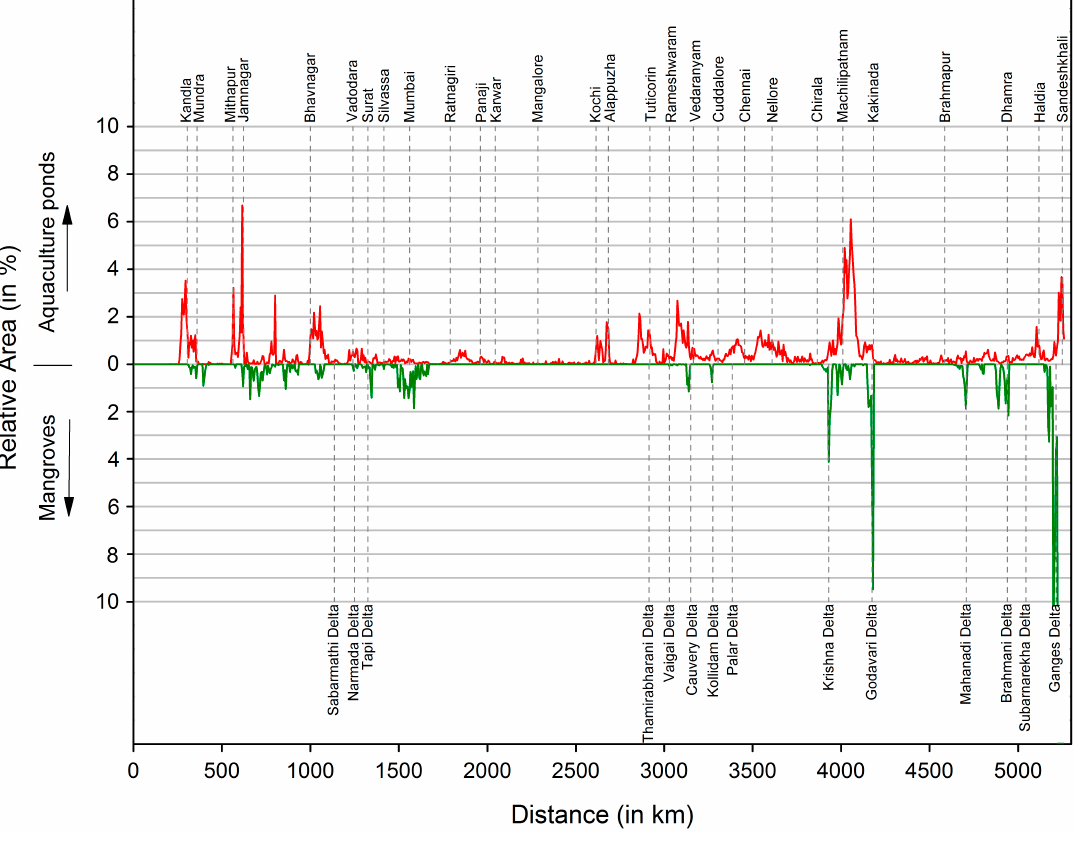
Figure 10. Spatial profile of aquaculture pond distribution along the Indian coast from west to east starting from Gujarat to West Bengal at 5-km intervals.